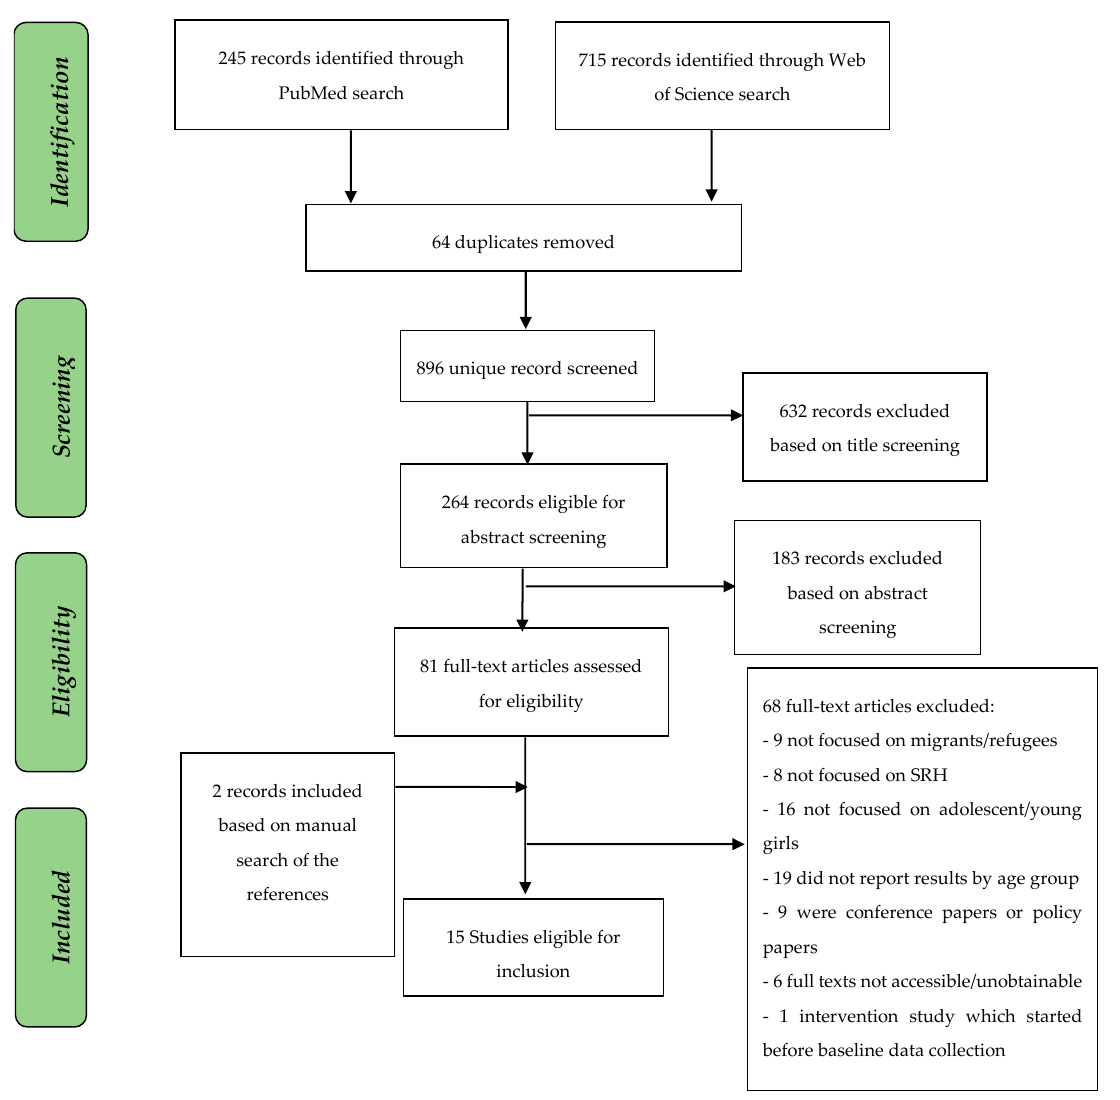
Figure 1. PRISMA Flow Diagram.